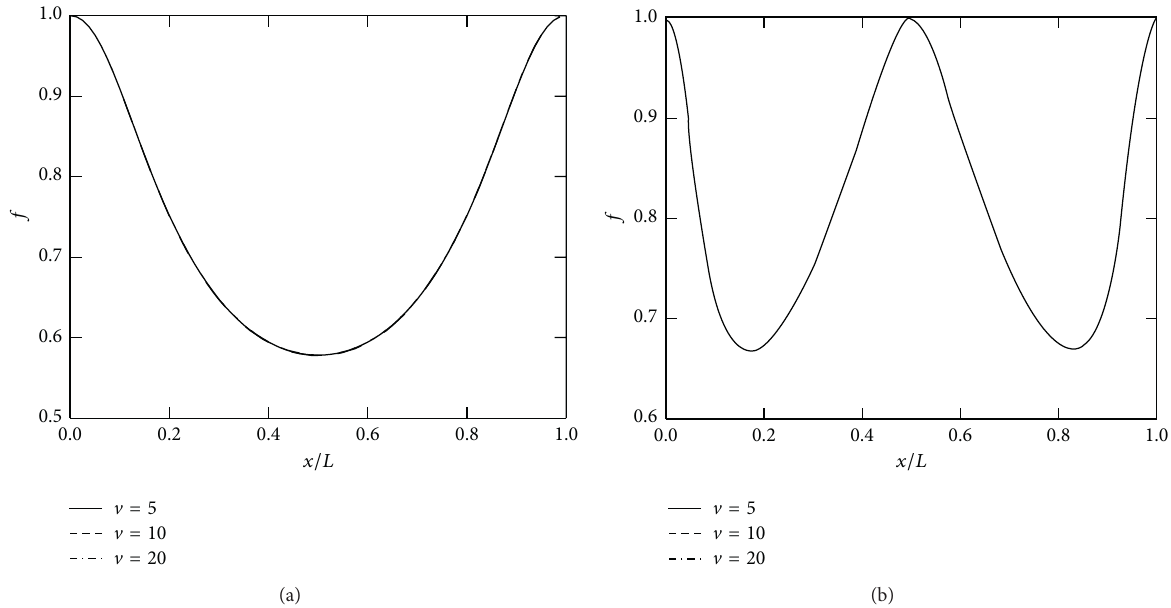
Figure 4: The first two normalized natural frequencies of simple-simple Timoshenko beam subjected to a moving mass with different